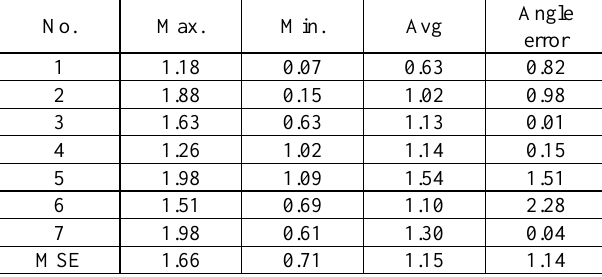
Table 2. The checking line residual in African